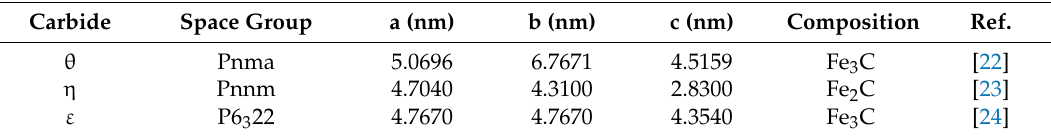
Table 1. Space groups and lattice parameters of carbides used for X-ray diffraction (XRD) pattern simulations with Fullprof.